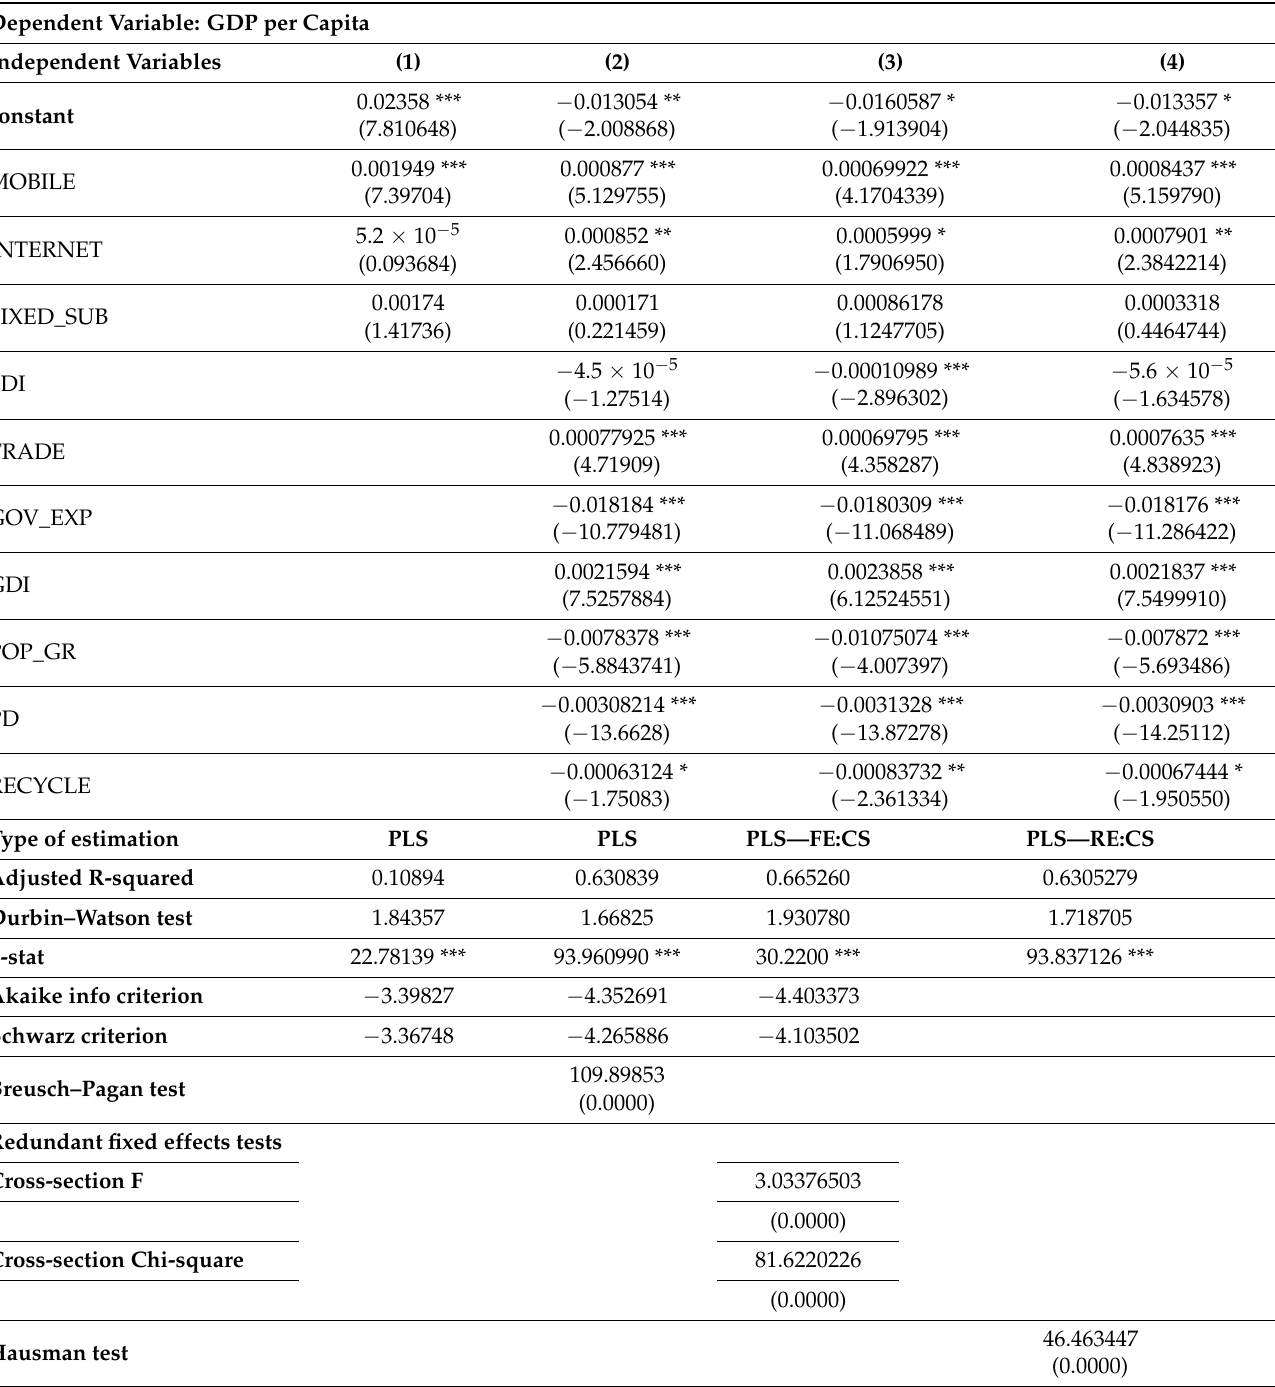
Table 6. Empirical results of panel regressions—EU-28